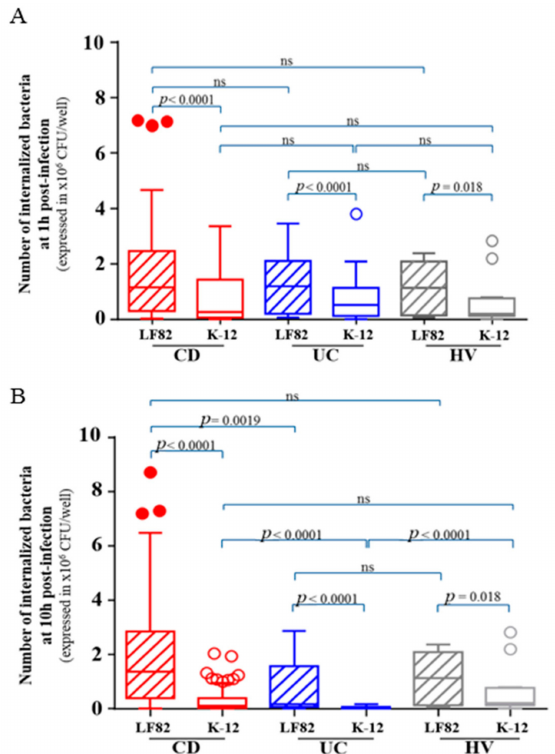
Figure 1. Number of internalized bacteria within macrophages at 1 h post-infection ( A ) and 10 h post-infection ( B ) in 95 CD patients, 30 ulcerative colitis patients and 15 healthy subjects. Statistical analysis was performed using Kruskall Wallis’ test and multiple comparisons and figure are performed using Tukey grouping. ns = not statistically